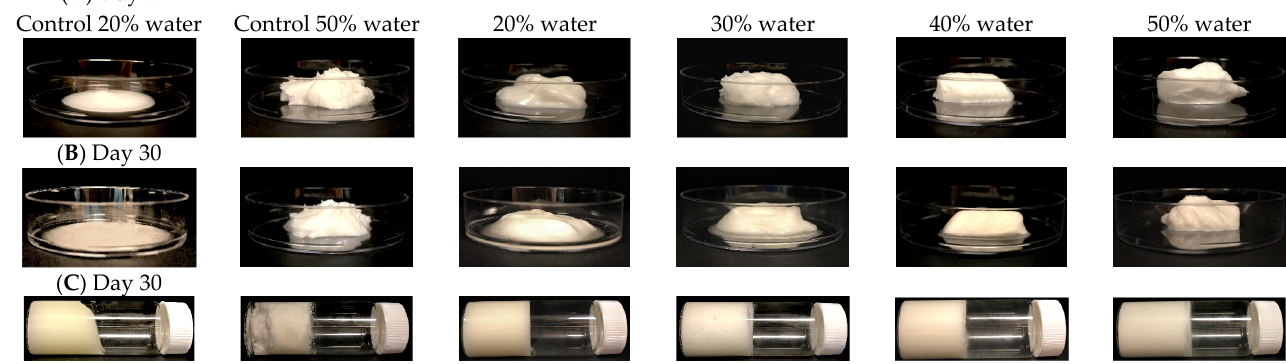
Figure 1. Stability of water-in-oil emulsions with different water volume fractions (20, 30, 40, and 50 wt.%) prepared with 1.5 wt.% LMP or without LMP for control emulsions, GMO, and 7 wt.% HSO. Petri dish on day 1 ( A ) and day 30 ( B ). Glass tube test flipped 90 degrees in parallel with the plane surface on day 30 ( C ).